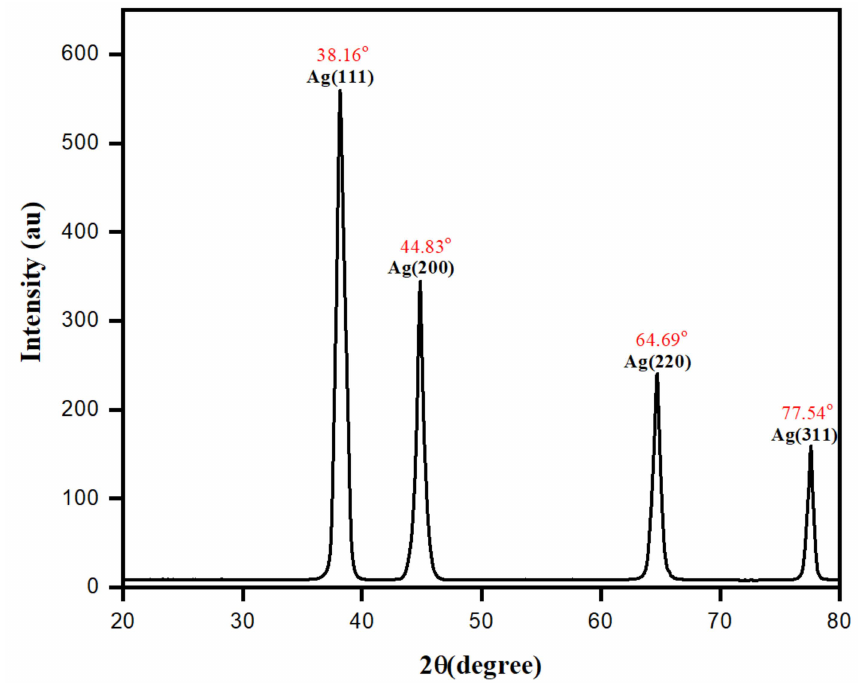
Figure 10. X-ray di ff raction (XRD) pattern of biomolecule-assisted